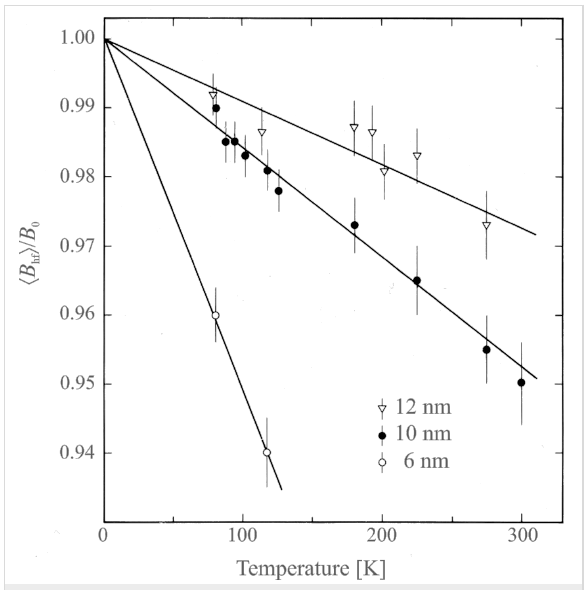
Figure 3: The reduced average magnetic hyperfine field as a function of temperature for particles of magnetite with sizes of 6 nm, 10 nm and 12 nm. The solid lines are the best linear fits to the experi- mental data in accordance with Equation 11. [Reprinted with permis- sion from Mørup, S.; Topsøe, H. Mössbauer Studies of Thermal Ex- citations in Magnetically Ordered Microcrystals, Appl. Phys. 1976, 11, 63-66. Copyright (1976) by Springer Science + Business